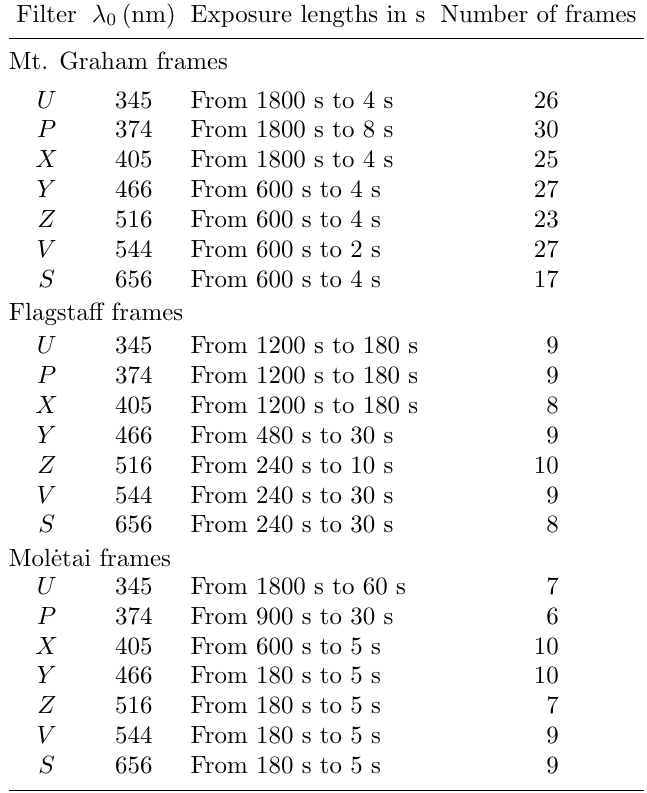
Table 1. Log of observations. The columns give the filter name, its mean wave- length, range of exposure lengths and the total number of frames in each filter. Filter (cid:21) 0 (nm) Exposure lengths in s Number of frames Mt. Graham